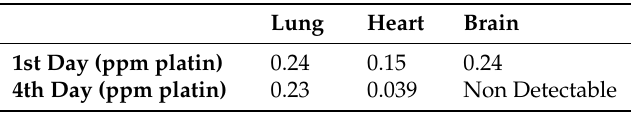
Table 1. Platin levels in 1 g of lung, heart, and brain